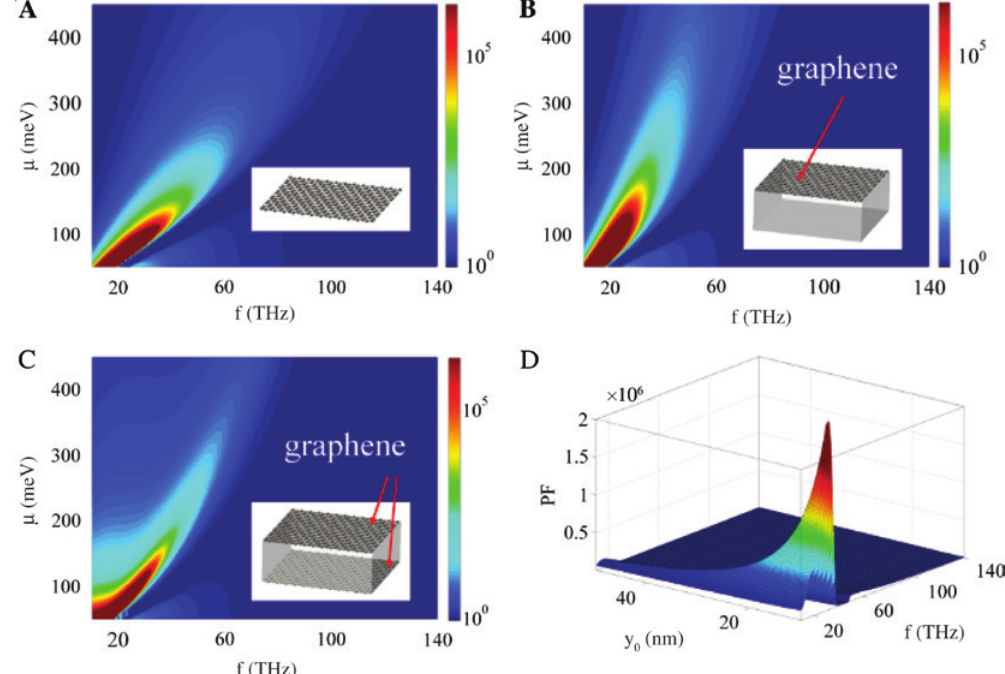
Figure 4: Emission-rate manipulation using graphene-based ultrathin planar structures. (A) PF for a suspended graphene layer in vacuum with a point source at 10 nm above the surface. (B) PF for graphene on a substrate with = 10 nm, ε = 4 and (C) for two layers of graphene separated by a 10 nm, ε = 4 spacer. (D) PF as a function of position ( y thickness d s point-source position above the surface) and frequency for the case in (b). Adapted with permission from Ref.